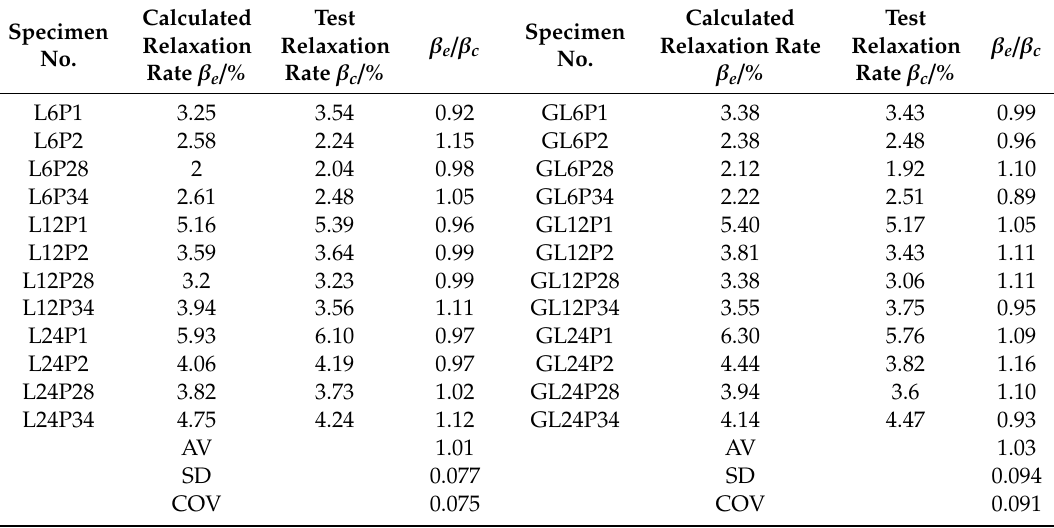
Table 8. Comparison of relaxation test values and calculation values.